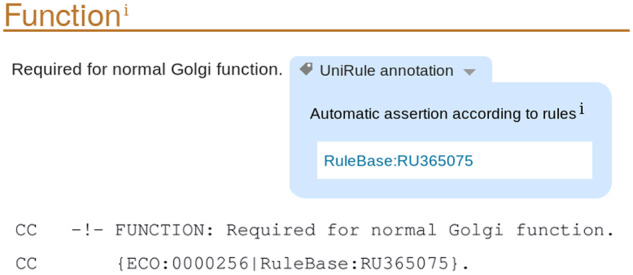
The representation in the UniProt website of evidence codes for annotation propagated by UniRule UR001001756. Above: Web page display; Below: Text version of the protein record